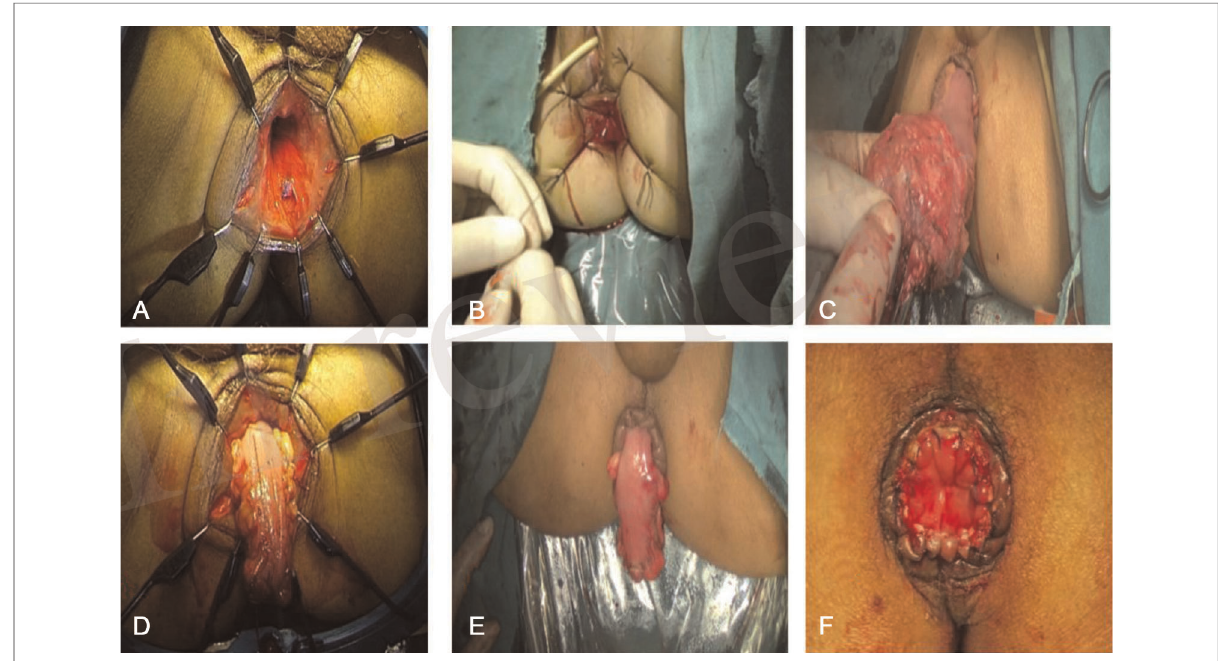
FIGURE 2 3D or 2D laparoscopic NOSES I-type E method to preserve the anus, ( A ) Full exposition of the anus; ( B ) Suturing the purse at the lower edge of the tumor; ( C ) Pulling out the rectum through the anus; ( D ) Removal of the specimen; ( E ) 5 cm of bowel was left outside the anus and fi xed with suture; ( F ) Picture of 14 days after anus